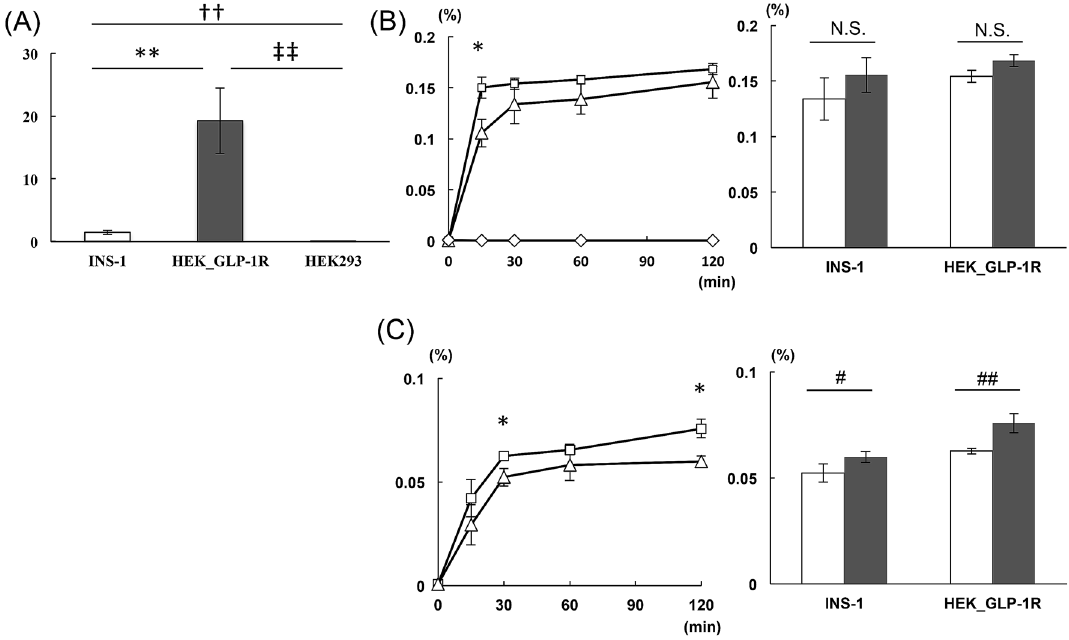
Figure 5. In vitro internalization of [ 18 F]FB(ePEG12)12-exendin-4. ( A ) Relative GLP-1R mRNA expression levels in INS-1, HEK293/GLP-1R(+), and HEK293/GLP-1R(−) cells (n = 6 for each group). INS-1, white bar; HEK293/GLP-1R(+), gray bar; HEK293/GLP-1R(−), black bar. **P < 0.01, †† P < 0.01, ‡‡ P < 0.01. ( B ) The changes in whole-cell radioisotope activity per incubated [ 18 F]FB(ePEG12)12-exendin-4 probe activities are shown in the left column (n = 6 for each group). The comparisons of whole-cell radioisotope activity per incubated probe activities between 30 and 120 min after incubation with the probe are shown in the right column. ( C ) The changes of cell-internalized radioisotope activity per incubated [ 18 F]FB(ePEG12)12-exendin-4 probe activities is shown in the left column (n = 6 for each group). The comparisons of cell-internalized radioisotope activity per incubated probe activities between 30 and 120 min after incubation with the probe are shown in the right column (n = 6 for each group). The data are expressed as the mean ± SEM. INS-1, square; HEK293/GLP-1R(+), triangle; HEK293/GLP-1R(−), rhombi. 30 min, white bar; 120 min, gray bar. § P < 0.05, radioisotope activities per